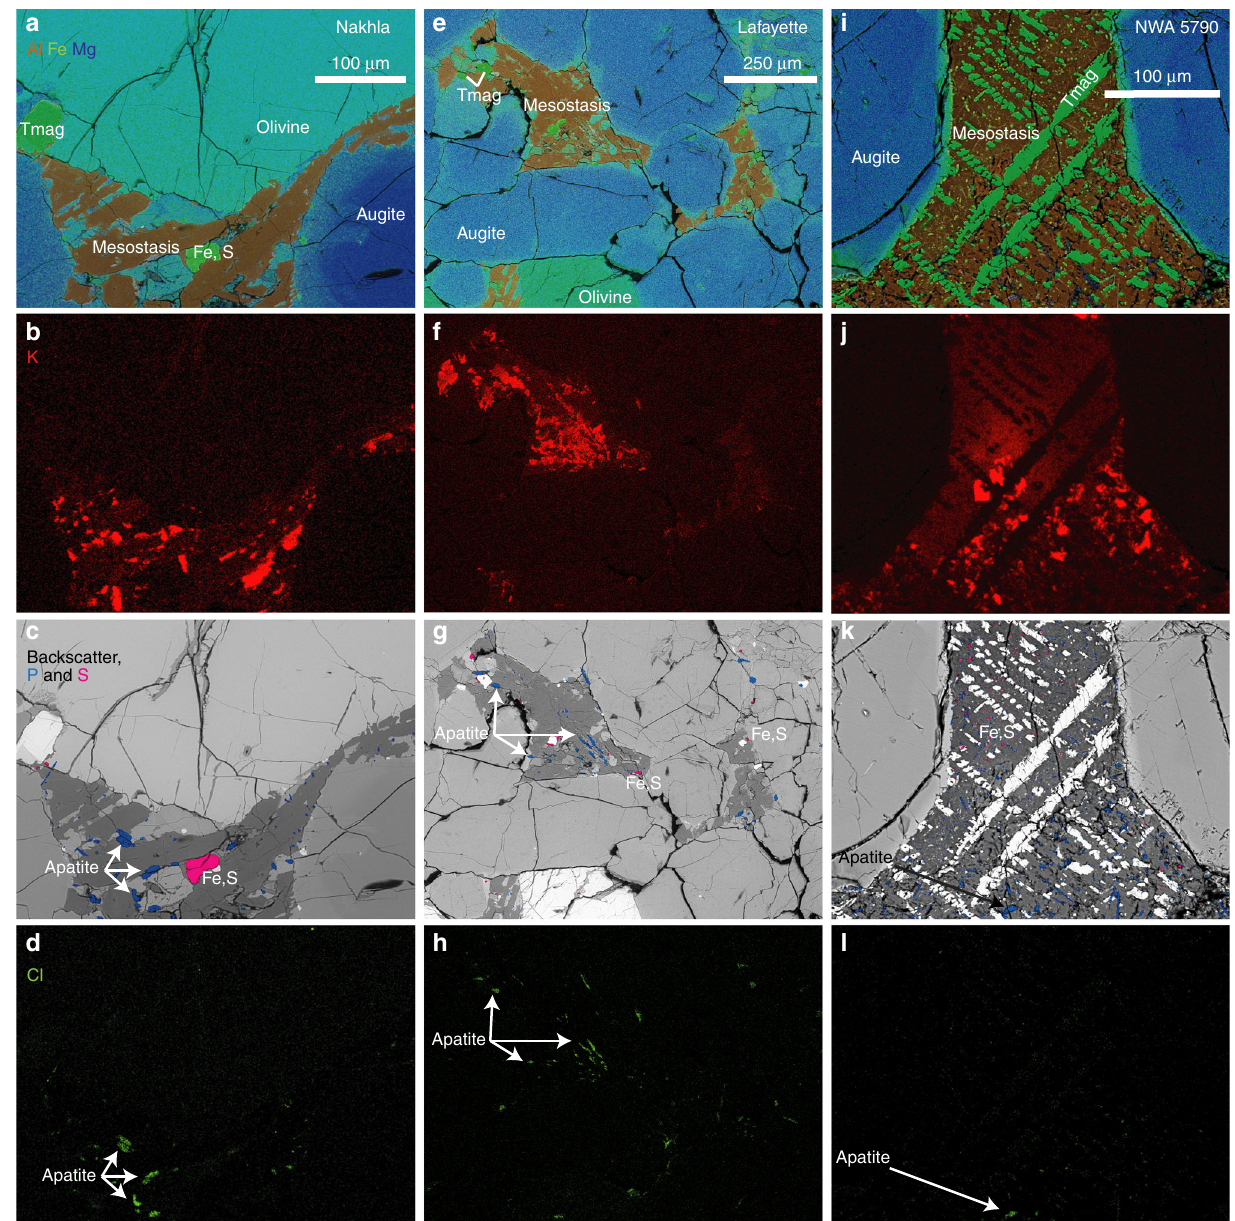
Fig. 2 Petrology of nakhlite meteorites. Panels a – d are scanning-electron microscope images of Nakhla; e – h are from Lafayette, and i – l show a representative area of NWA 5790. Images from the other meteorites (MIL 03346, Yamato 000593 and Yamato 000749) are in Supplementary Fig. 1. Panels a , e , i display the distribution of aluminium ( brown ), iron ( green ) and magnesium ( blue ); panels b , f , j show potassium ( red ); panels c , g , k illustrate the distribution of phosphorus ( blue , concentrated in apatite) and sulphur ( magenta , in iron sulphide), as well as the backscattered electron intensity in grey ; and panels d , h , l show the distribution of chlorine ( green , in apatite). These images illustrate that the nakhlite meteorites are igneous rocks, dominated by euhedral augite crystals set in a fi ne-grained mesostasis. The augite crystals ( deep blue , in a , e , i ) are often zoned, with an outer rim of ferroan pigeonite. Olivine crystals are also present, but less common. Potassium is concentrated in mesostasis feldspar. The mesostasis also contains crystals of titanomagnetite (Tmag), iron sulphide (Fe,S) and chlorine-bearing apatite. As potassium and chlorine are both dominantly hosted in the mesostasis, the argon gas derived from radiogenic decay of potassium and chlorine gas from apatite will be closely associated in location and thermal behaviour during a 40 Ar/ 39 Ar experiment, and the contribution from chlorine must therefore be accounted for during the cosmogenic argon correction procedure